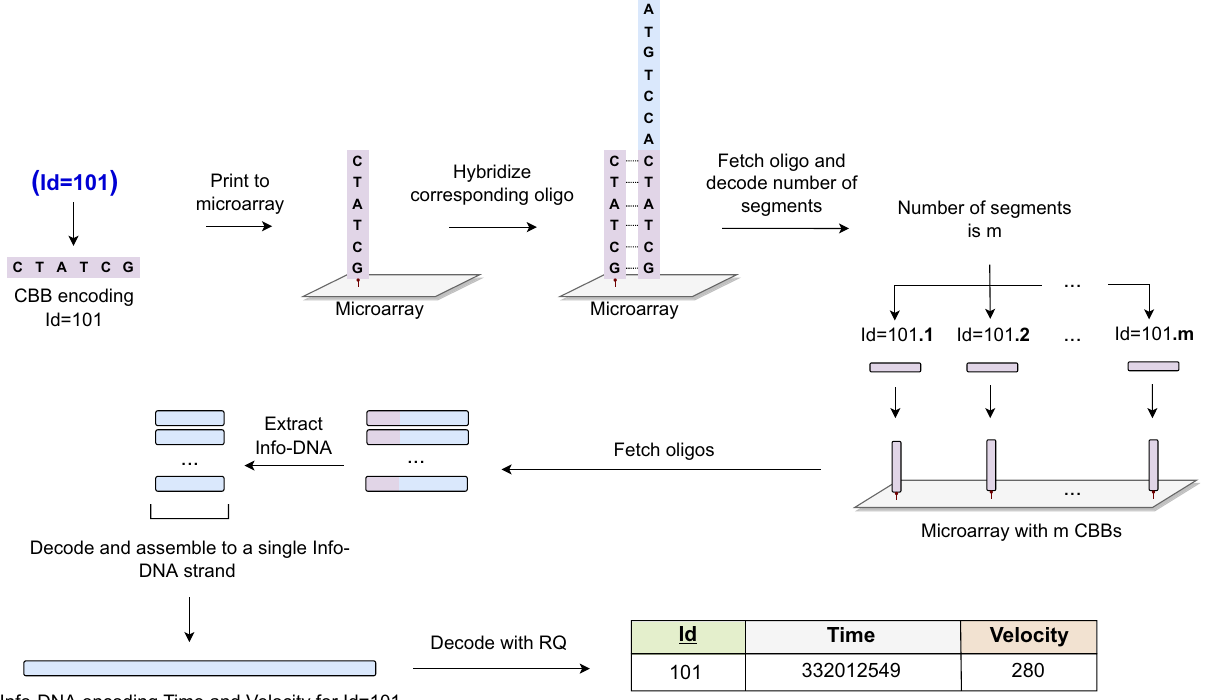
Figure 3. The figure depicts an example of how to answer the filter query (Id=101) on the unique attribute Id in Fig. 2a that is encoded with segmentation. First, the predicate given in the query ( Id=101 ) is printed on a microarray, and the matching oligo is fetched. This strand contains the number of segments m that encodes the desired record. After decoding it, the remaining segments are retrieved by fetching the CBBs encoding